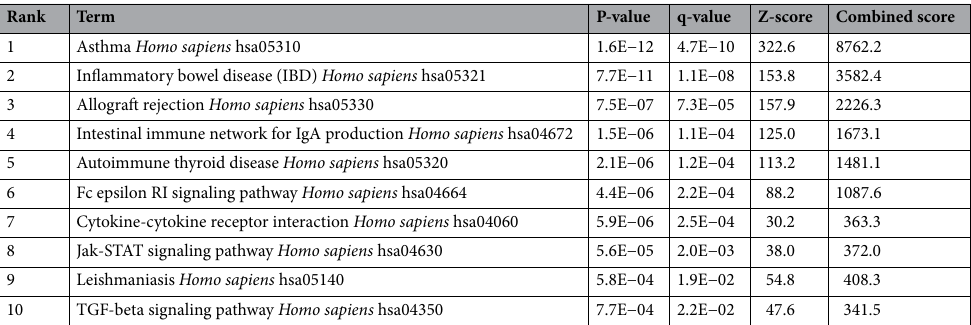
Table 4. Top enriched human KEGG pathways for genes enriched from MSEA analysis using DA microbes in IL-1α-KO versus WT mice 8 days after DSS-administration.